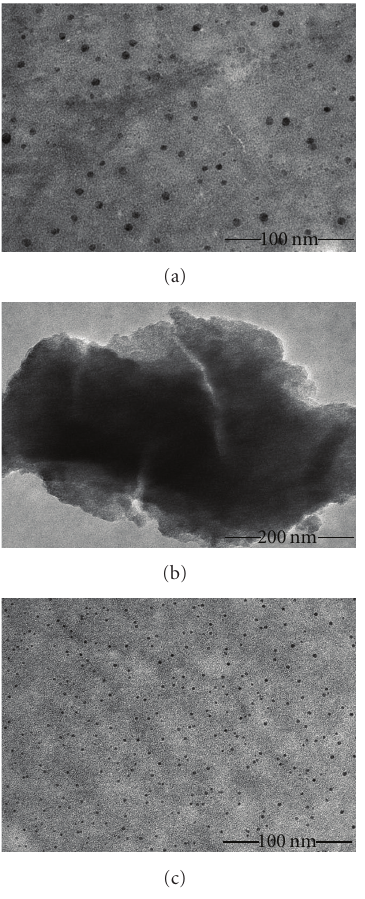
Figure 3: TEM micrograph for (a) STAB at 45KX, (b) STA-SG at 35KX, and (c) STA-SG at 45KX. Table 2: Percentage of mass concentration (%) of C1s, O1s, Si2p and W4f elements from wide scan analyses for STAB and STA-SG catalysts.